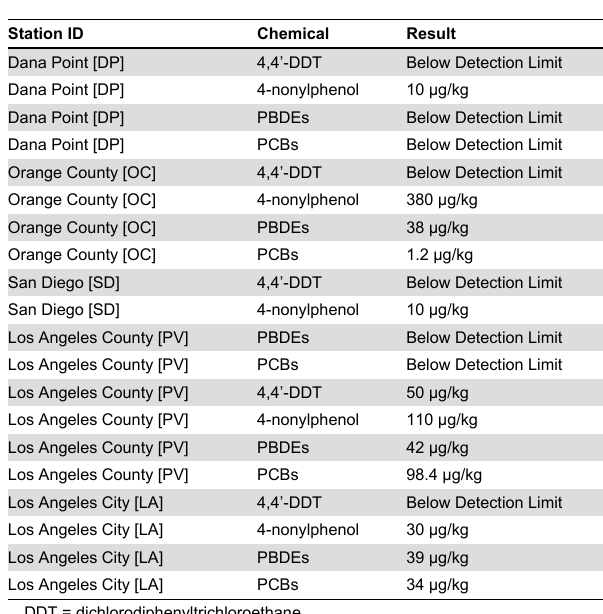
Table 2. Chemical analysis of sediments from the sites where the fish were